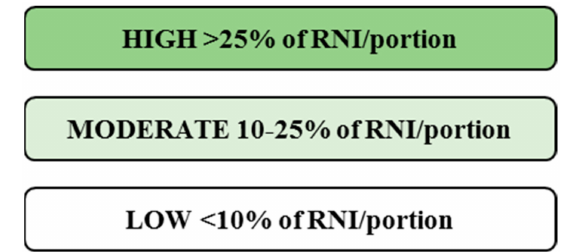
Figure 1. The criteria of product classification to high, moderate, and low contribution to realization of daily requirements for Ca, Fe, Mg, and